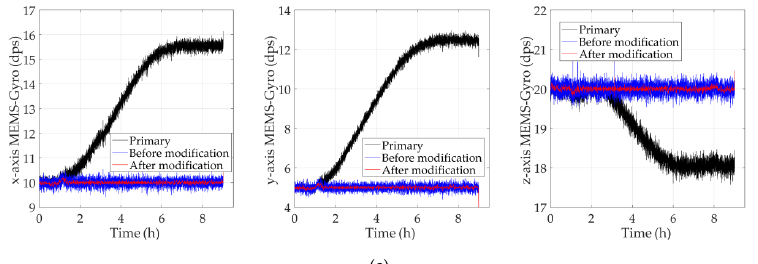
Figure 12. Comparison of the test results in five experiments. ( a ) 1st experiment; ( b ) 2nd experiment; ( c ) 3rd experiment; ( d ) 4th experiment; ( e ) 5th experiment.